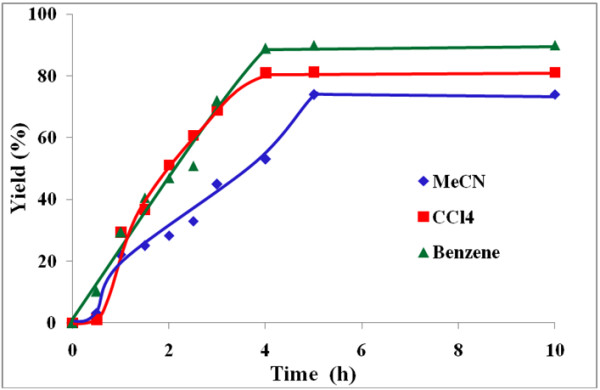
Effect of solvent on % yield of benzil using VOL3 at 50°C.